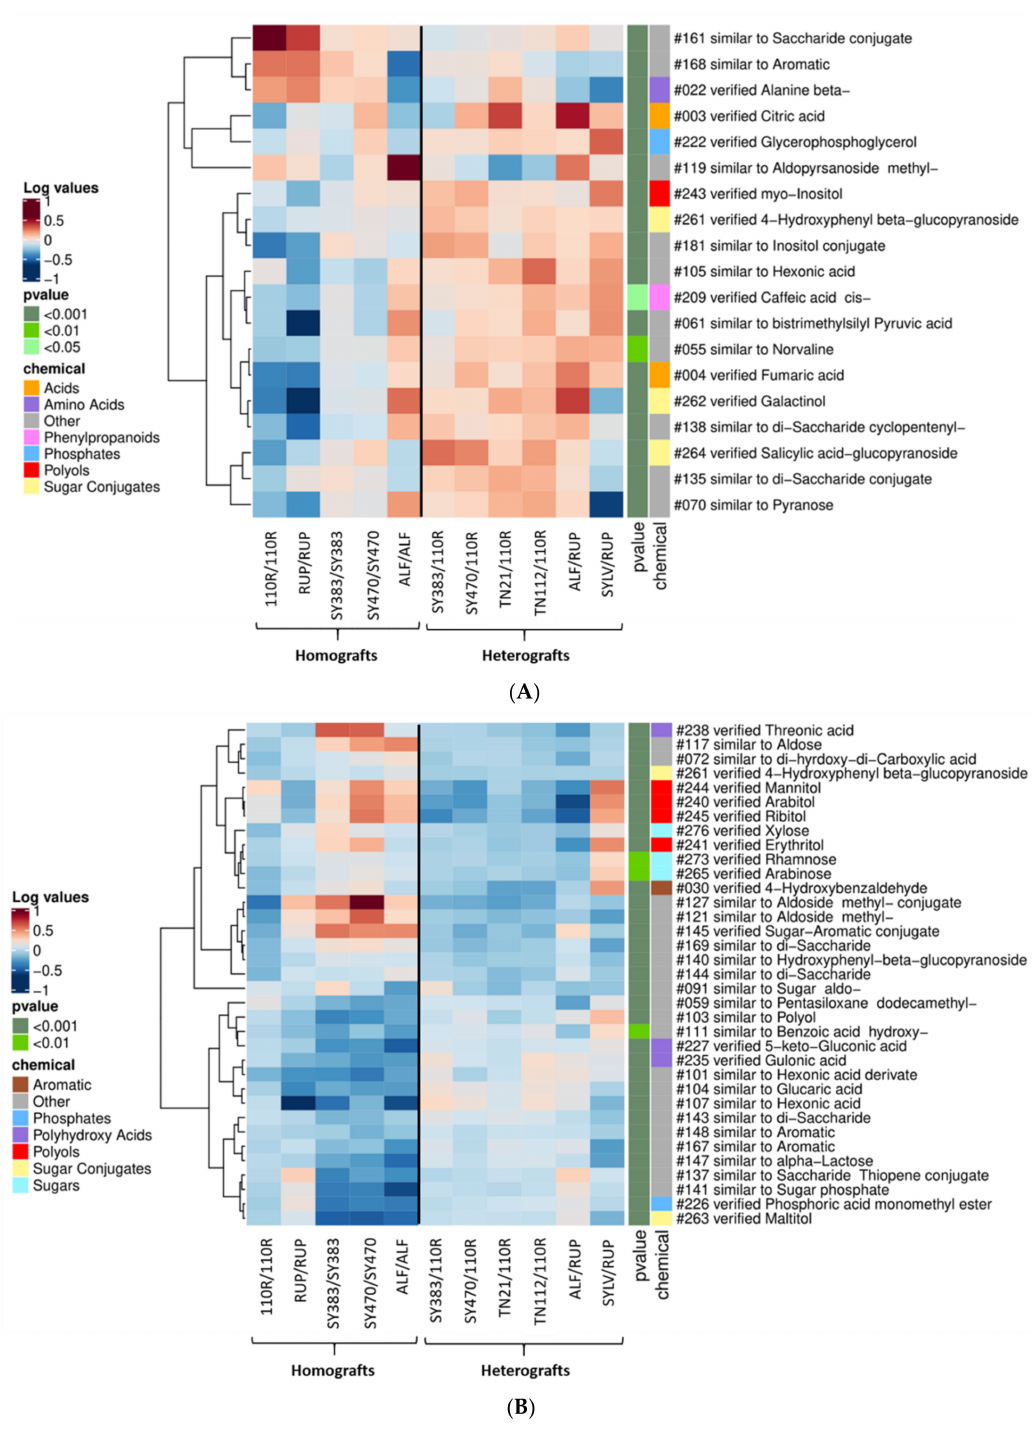
Figure 2. Heat map clustering analysis of homografts versus heterografts at 5–6 months after grafting: ( A ) in the scion stems ; ( B ) the rootstock stems ’ datasets. Scion and rootstock stems’ metabolites found increased or decreased in at least 80% of the homograft combinations and less than 20% of the heterografts (i.e., n = 19 and 35, respectively). Selected metabolites were retrieved from all metabolites found significantly different in at least 1 scion and rootstock stem paired-comparison of a homograft versus a heterograft at p < 0.05 according to Tukey post hoc test (i.e., n = 157 and 159, respectively). Mean log 10 -transformed values per graft combination are plotted, as well as the p -value range (<0.05, <0.01, and <0.001) and the potential chemical class (“chemical”) of plotted metabolites. Not-verified metabolites (named with the prefix “similar to”) were included in the chemical class assigned as “Other”. Cluster analysis of metabolites was performed using the Pearson correlation